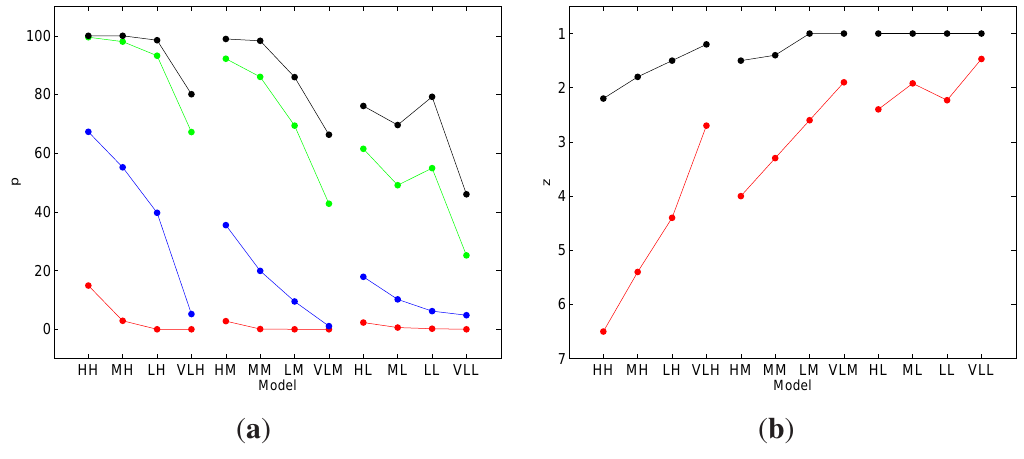
Figure 11. Evolution of the mass assembly in the reference models. The X axis lists the models ordered as in Table 1 (the acronyms have been shortened for reasons of